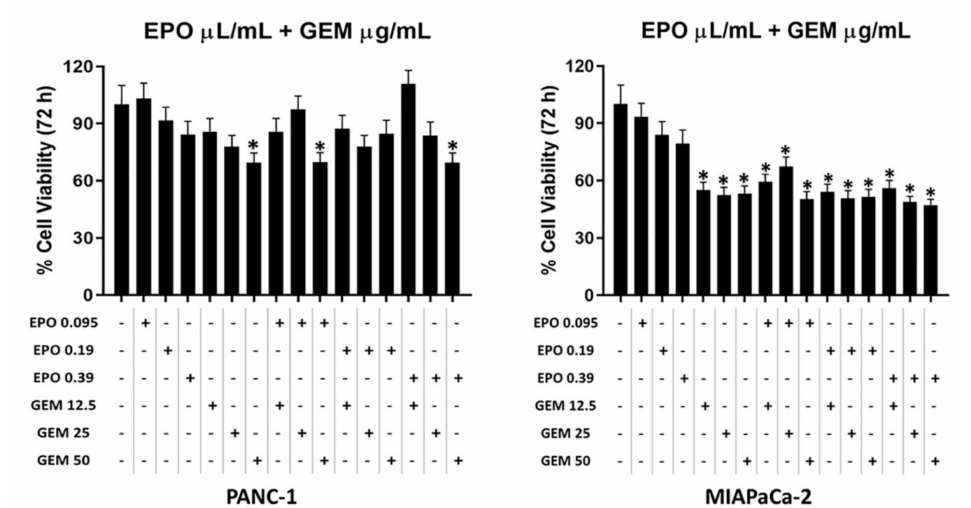
Figure 5. Evaluation of the effect of GEM and EPO combinations on PANC-1 and MIAPaCa-2 cell viability. Data shown are expressed as the mean ± SD of three separate experiments. * p < 0.05 treated PANC-1 or MIAPaCa-2 vs.